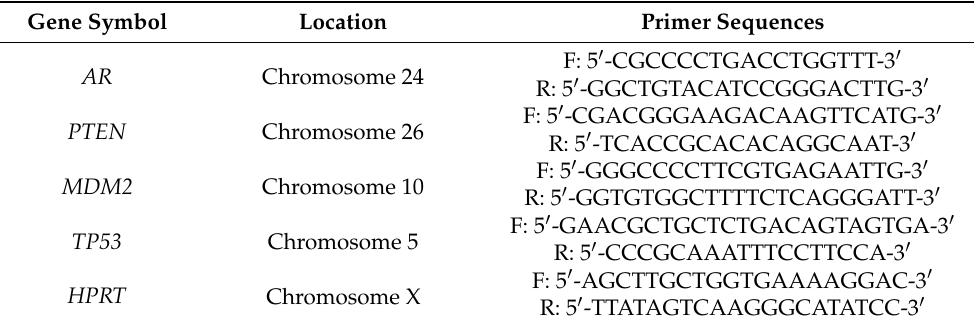
Table 2. Forward and reverse primer sequence for each gene used in RT-qPCR